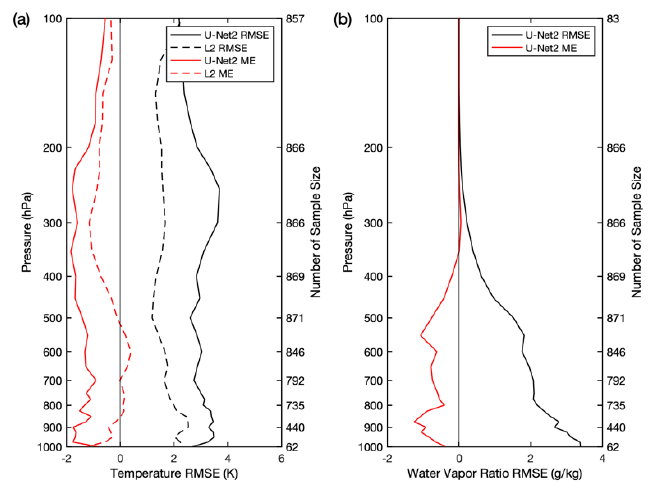
Figure 16. Temperature ( a ) and water vapor mixing ratio ( b ) retrieval error profiles compared with radiosonde under clear FOVs for July 2021. The red lines are ME profiles, the black lines are the RMSE profiles. The solid line is U-Net 2 scheme and dashed line represents the L2 operational